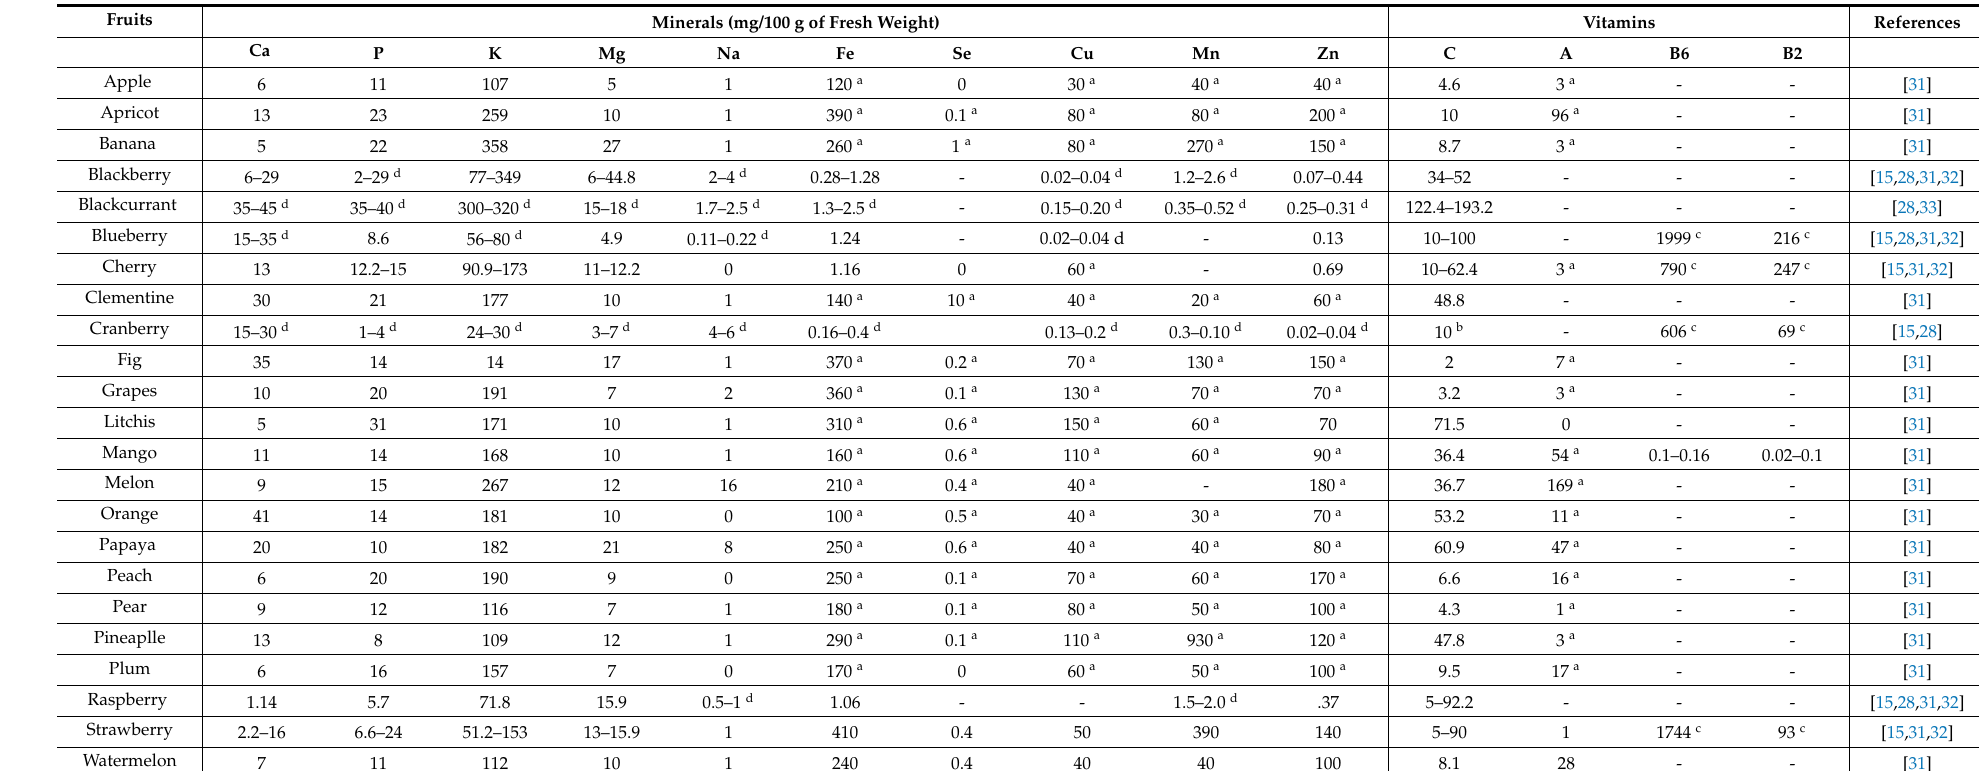
Table 1. Mineral and vitamin composition of different fresh